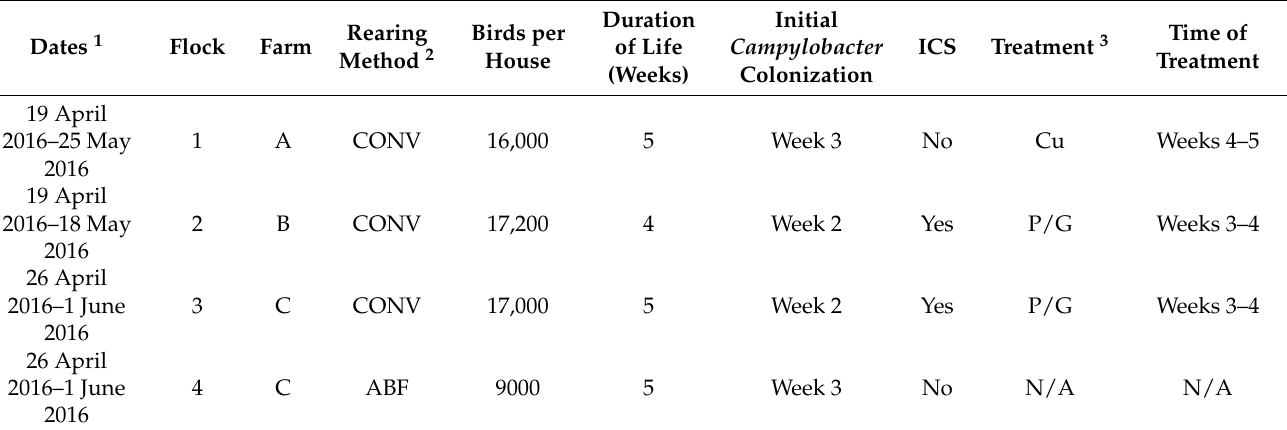
Table 1. Turkey flocks investigated in this